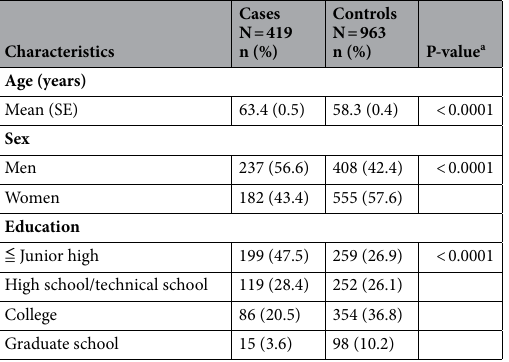
Table 1. Demographic characteristics of the pancreatic cancer patients and control subjects. N number, SE standard error. a P-values were generated using T-tests (for continuous variables) or chi-squared tests (for categorical